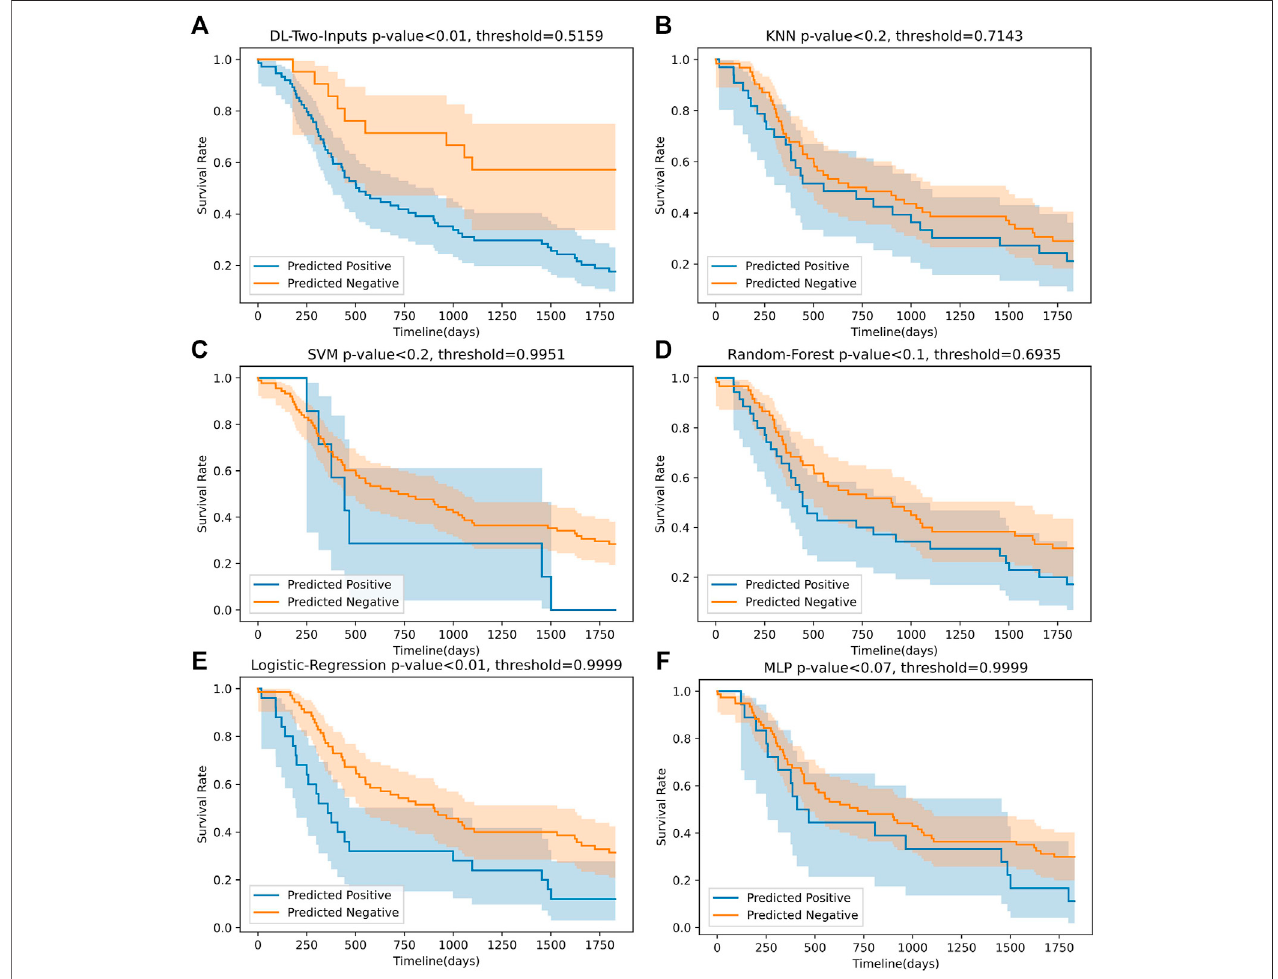
FIGURE 6 | The Kaplan – Meier curves of the predicted high-risk and low-risk samples for our best DL model (without clinical data) and the fi ve ML models on the TCGA lung cancer data set. The p -values were computed using log-rank test.